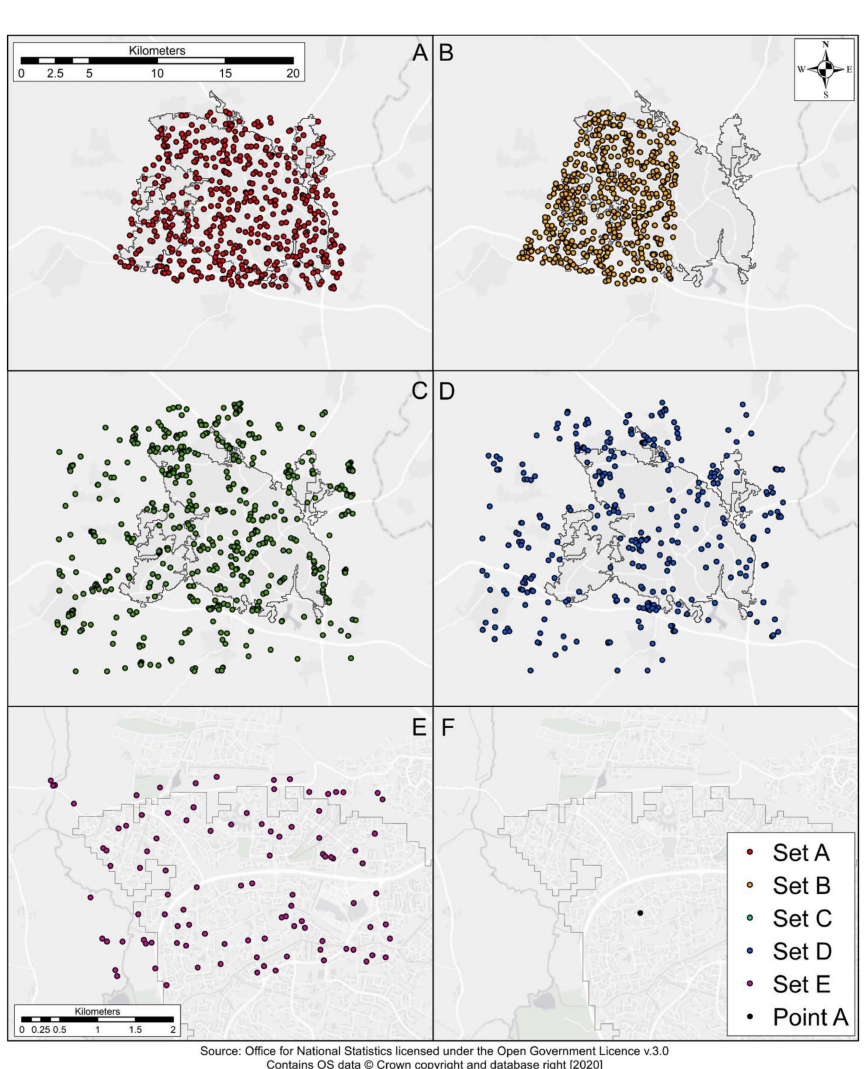
Figure 2. Location of the ground truth and accuracy assessment points used. ( A ) The 500 points used to assess the threshold values. ( B ) The 500 points used in accuracy assessment of the model and PCC. ( C ) The 500 training data points selected from the change class for classification. ( D ) The 300 points used in accuracy assessment of the change classification. ( E ) The 100 points selected from the Haydon Wick area to assess the accuracy of dating of change (selected from location B in Figure 1). ( F ) The single point chosen from Set B to demonstrate the methodology (Figure